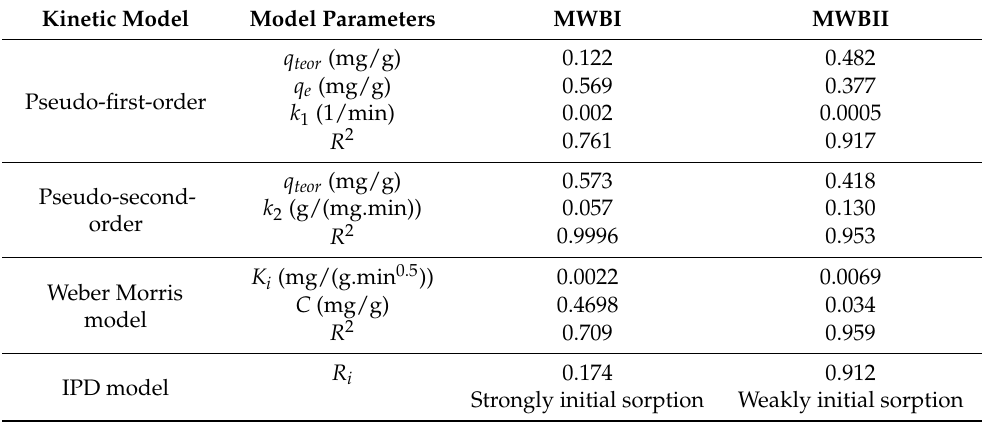
Figure 6. Sorption rate of Be(II) ions on the MWBI and MWBII calculated by ( a ) the PFO and ( b ) the PSO kinetic models. Table 3. Kinetic parameters of the PSO kinetic model determined by linear regression.